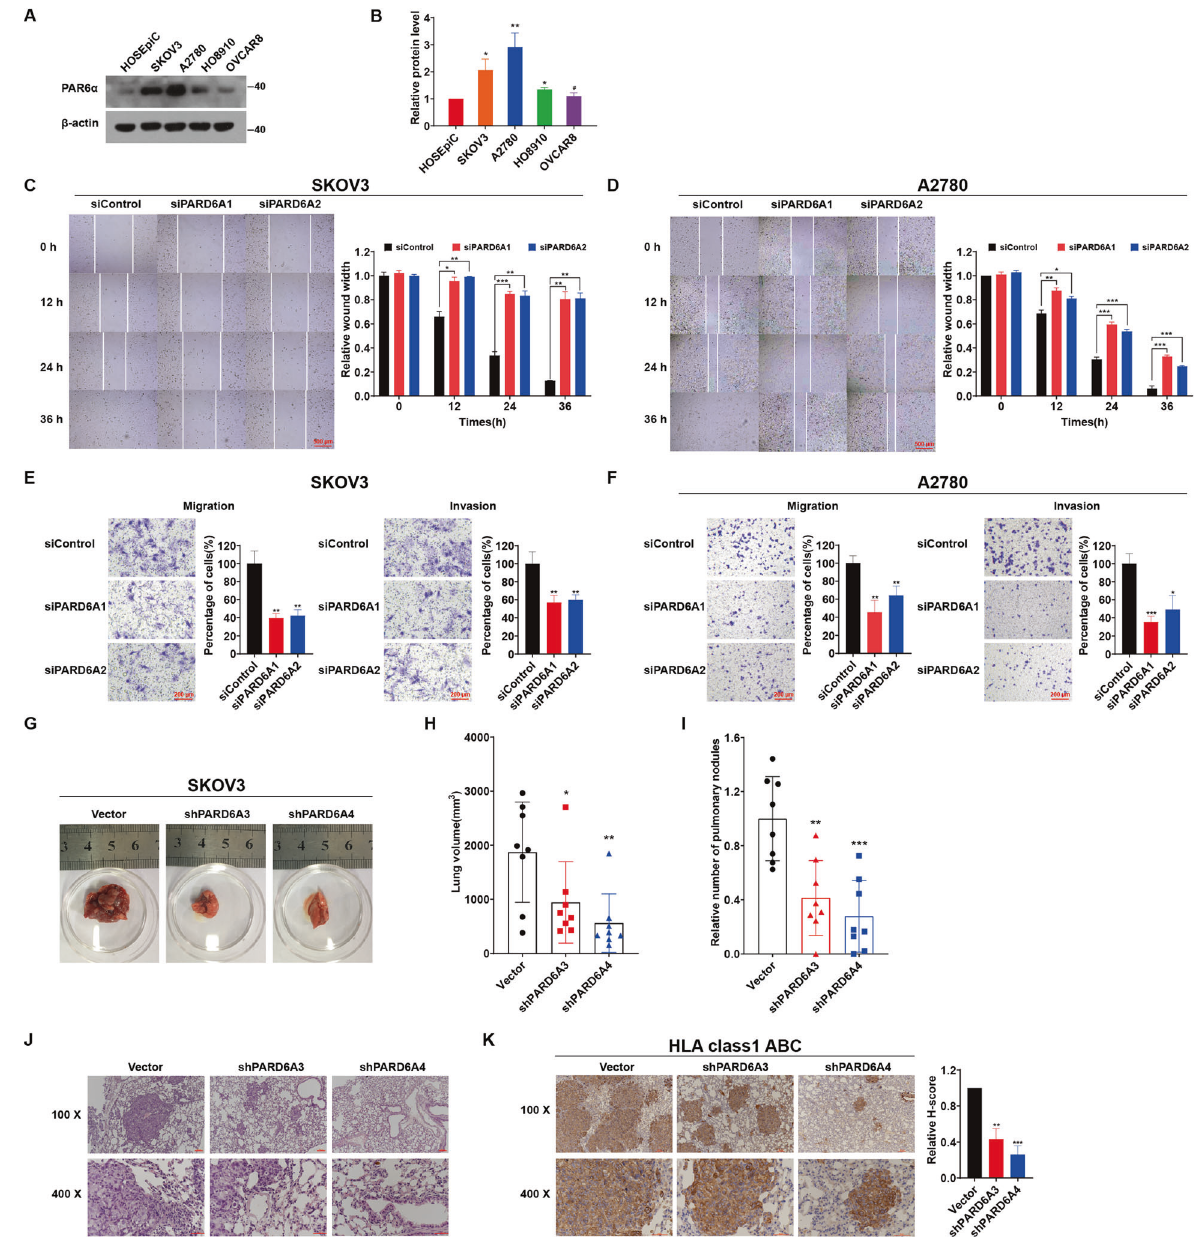
Fig. 2 PARD6A knockdown suppresses EMT of ovarian cancer cells in vitro and in vivo. A Protein levels of PAR6 α in ovarian cancer cell lines (SKOV3, HO8910, OVCAR8 and A2780) and normal ovarian surface epithelial cell line HOSEpiC. Above cells were collected and protein lysates were subjected to immunoblot analysis with the PAR6 α antibody. B Densitometric analysis of the immunoblots ( A ) was conducted using ImageJ to quantify PAR6 α levels relative to β -actin in ovarian cancer cell lines. Representative pictures and statistical analysis of wound-healing assays on SKOV3 ( C ) and A2780 cells ( D ), which were silenced with siPARD6As, at the indicated time. Scale bar = 500 µm. Representative pictures of transwell migration and invasion assays and statistical analysis of transwell migration and invasion assays on SKOV3 ( E ) and A2780 cells ( F ) silenced by siPARD6As. Scale bar = 200 µm. G Representative images of lung metastases of ovarian cancer cells in mice. H Statistics of volumes of lungs of each group of mice at the indicated time. I Pulmonary nodules of each group of mice. J Representative images of H&E staining of paraf fi n sections of mouse lung tissues in each group. Scale bar = 100 µm (×100) and scale bar = 50 µm (×400). K Immunohistochemical detection of HLA class1 ABC in mouse lung tissues. Data are expressed as the H-Score, considering both staining intensity and the percentage of positively staining cells. Scale bar = 100 µm (×100) and scale bar = 50 µm (×400). Data shown in this fi gure are the mean values (±SD) from three independent experiments. Statistically signi fi cant differences with P < 0.05 were considered signi fi cant (* P < 0.05; ** P < 0.01; *** P < 0.001). Overexpression of PARD6A promotes EMT of ovarian cancer ( P < 0.01 for shPARD6A3 and P < 0.001 for shPARD6A4) (Fig. 2K). cells in vitro These results con fi rmed that the pulmonary nodules of the mice To further con fi rm that PARD6A plays an important role in were formed by SKOV3 ovarian cancer cells. In sum, knockdown migration and invasion of ovarian cancer cells, the constructs were of PARD6A gene suppressed EMT of ovarian cancer cells in vitro built to overexpress PARD6A in ovarian cancer cell lines. Both and in vivo. Cell Death and Disease (2022)